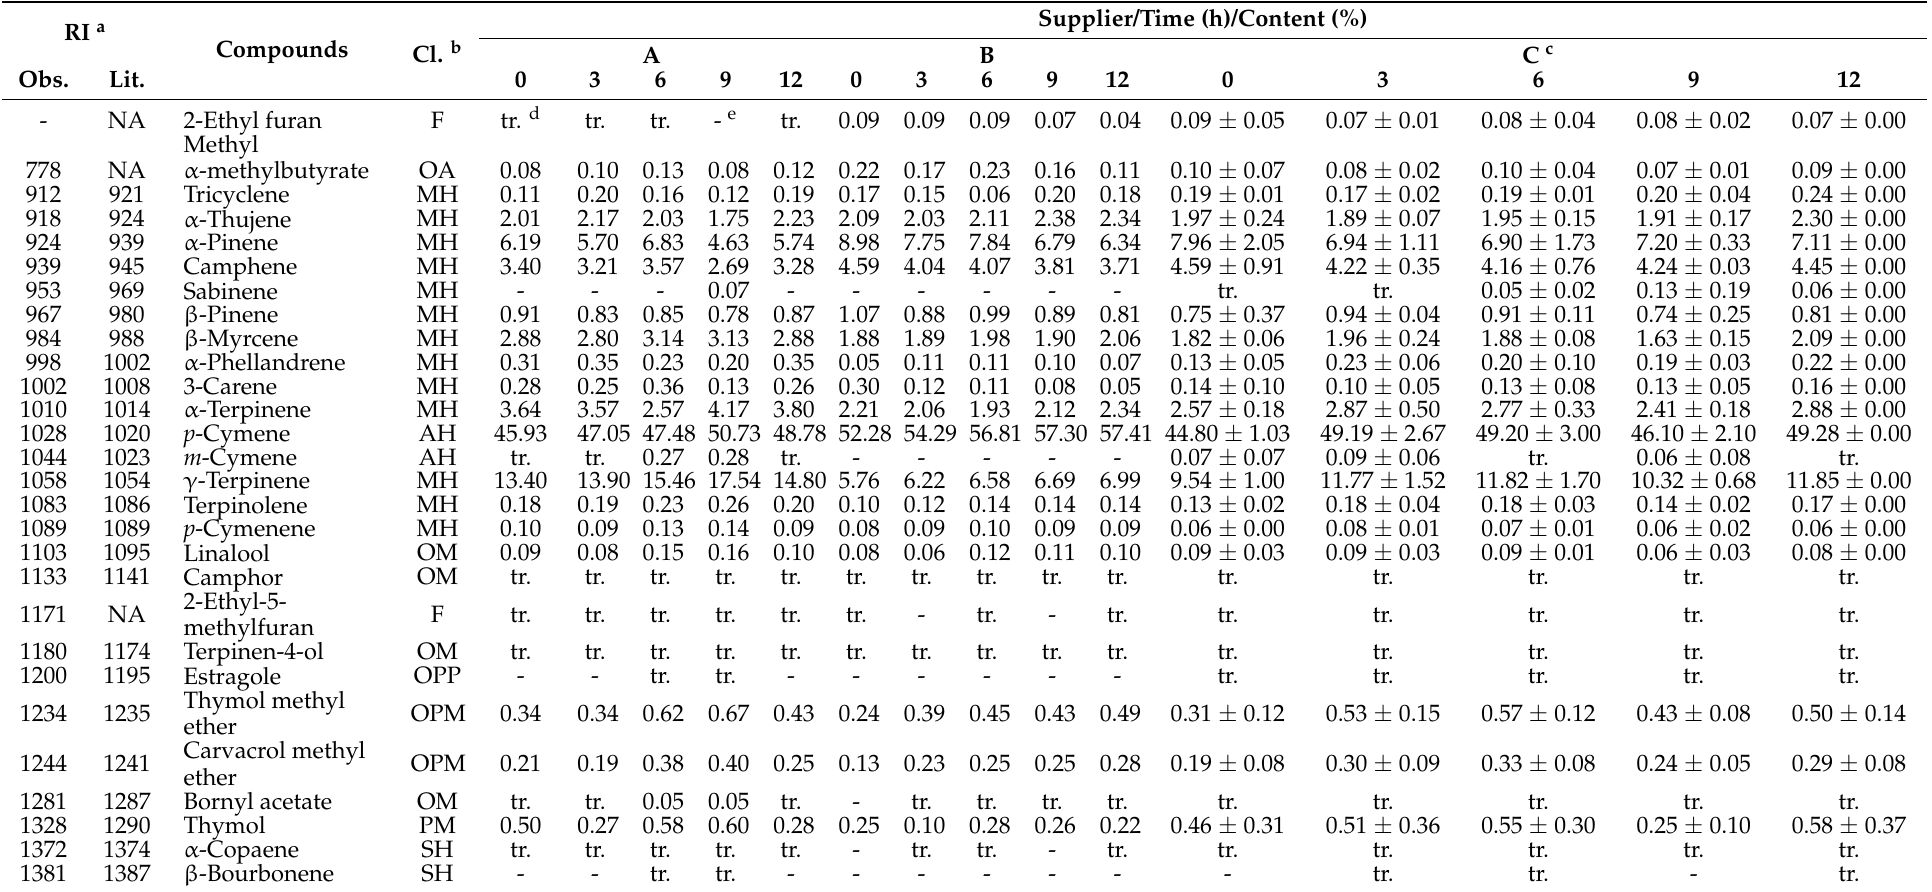
Table 4. Chemical composition of the headspace above a mixture of Mueller–Hinton broth and Thymus vulgaris L. essential oils at a concentration of 512 µ g/mL over a 12-h period using gas tight syringe headspace sampling